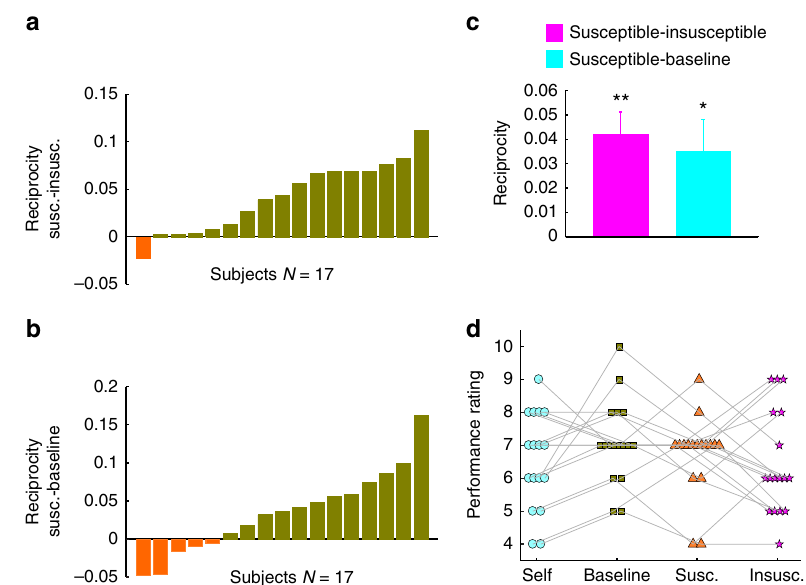
Fig. 2 Results of experiment 1. a Reciprocity, computed as in fl uence in the susceptible condition minus in fl uence in the insusceptible condition, plotted across participants. b Reciprocity, computed as in fl uence in the susceptible condition minus in fl uence in the baseline condition, is plotted across participants. c Average reciprocity across participants in insusceptible and baseline conditions compared to the susceptible condition. Error bars indicate the standard errors and were computed across the participants ’ average reciprocities. * p < 0.05, ** p < 0.005; Wilcoxon sign rank test. d Performance ratings for self and all partners as reported at the end of the